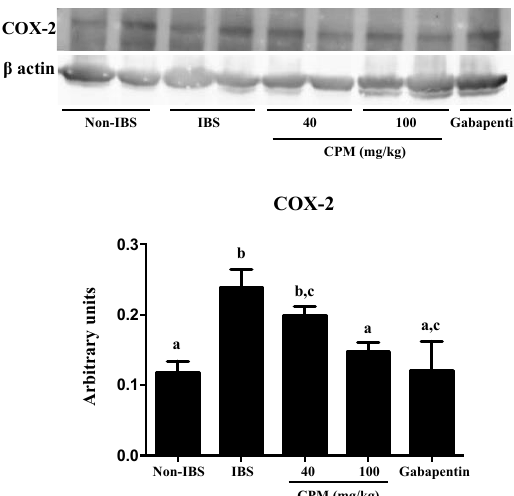
Figure 4. Effects of CPM (40 mg/kg and 100 mg/kg) and gabapentin (70 mg/kg) on COX-2 protein expression (Western blot) in rats two weeks after DCA administration. Experiments were performed in triplicate. The quantification of bands was performed by densitometric analysis using ImageJ software. Data are expressed as means ± SEM ( n = 6). Groups with different letters differ statistically ( p <